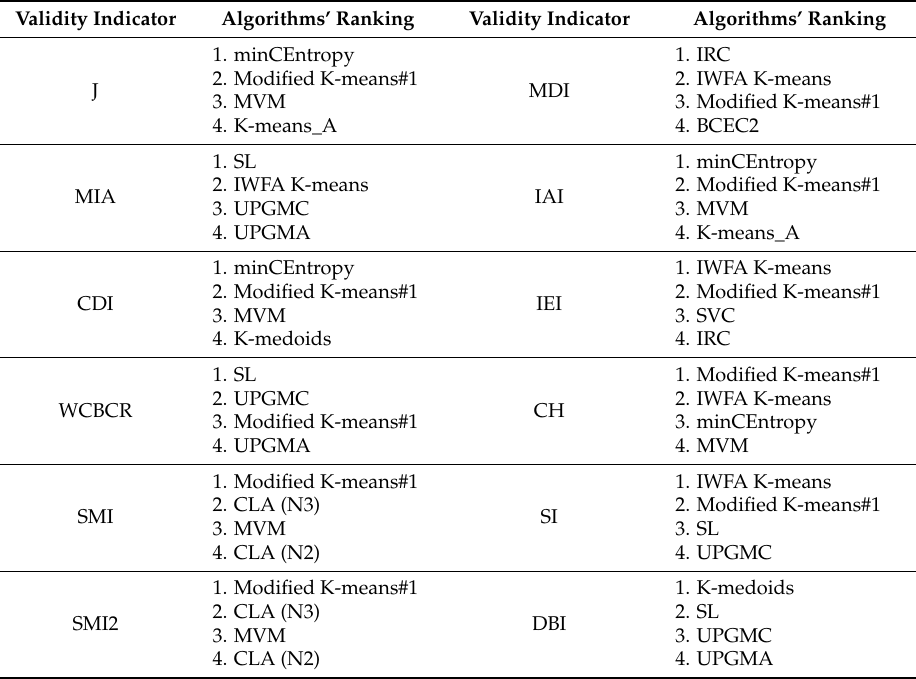
Table 8. Algorithms ranking per validity